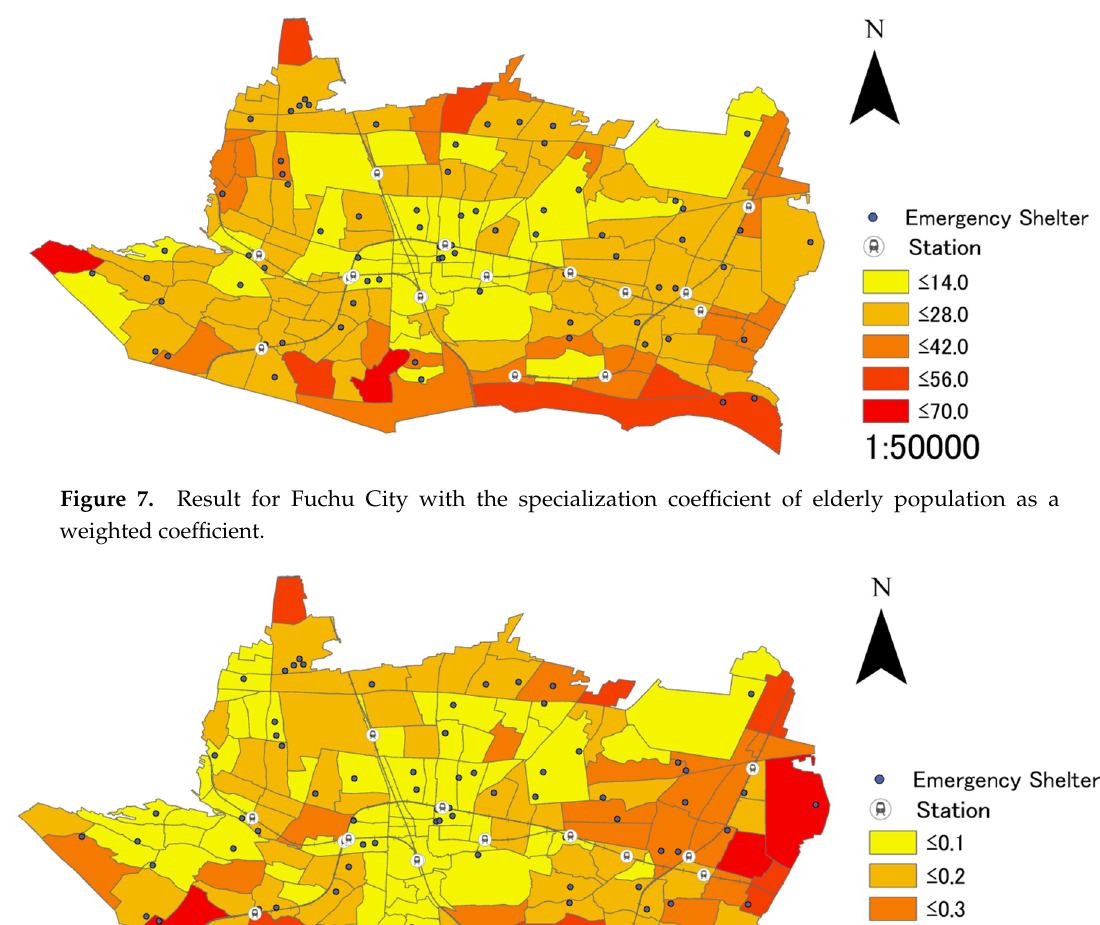
Figure 6. Result for Fuchu City without a weighted coefficient.